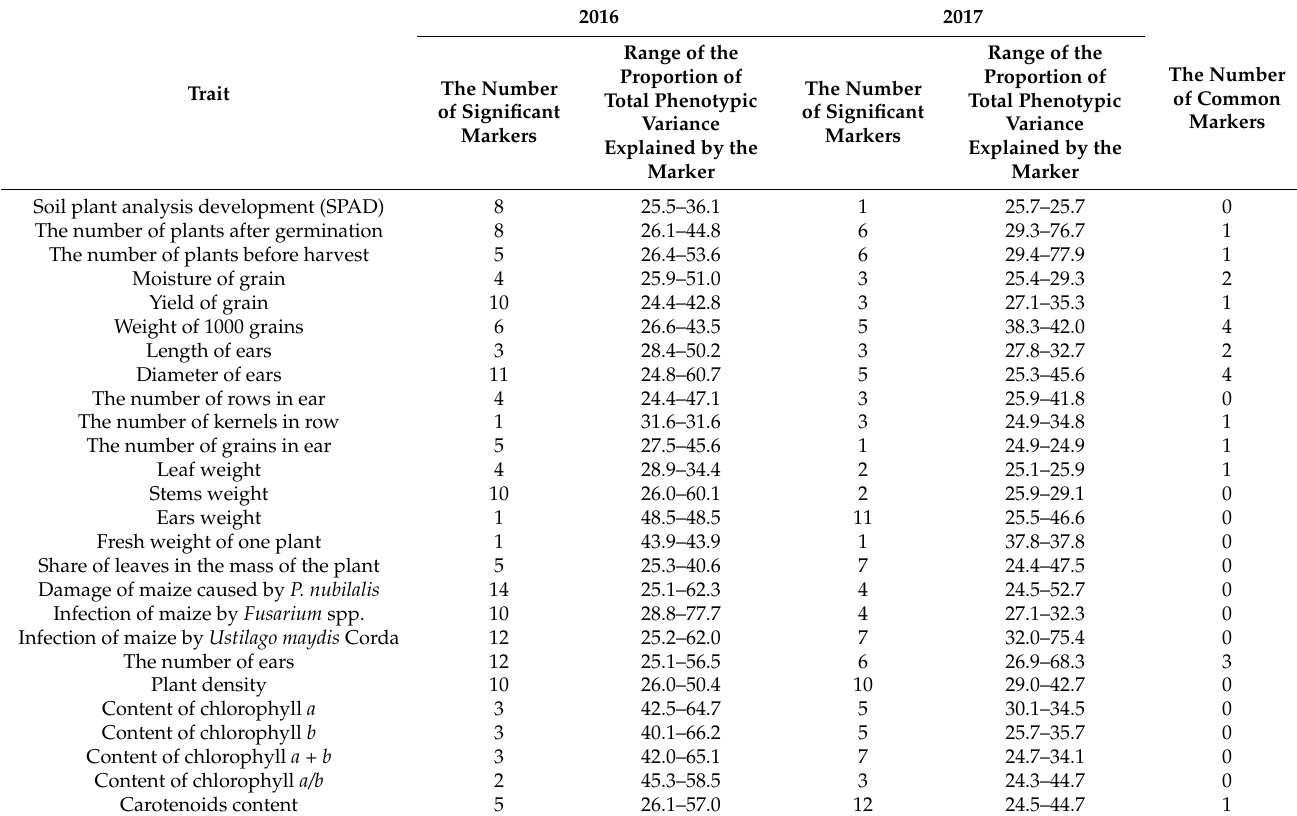
Table 2. The number of molecular markers associated with 26 observed traits of maize ( Zea mays L.) in two years of study.